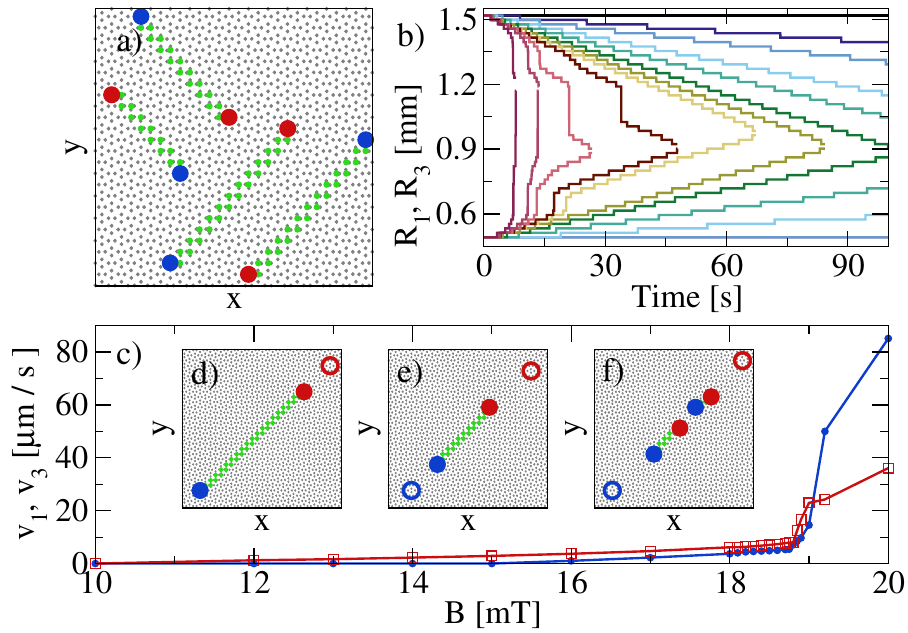
Figure 2. Defect line images and motion. ( a ) The four possible arrangements of the defect lines in a portion of the sample. Red: 3-in vertex; blue: 1-in vertex; green: biased ground state vertex; gray: unbiased ground state vertex. ( b ) The position R 1 of the 1-in (bottom lines) and R 3 of the 3-in (top lines) ends of a defect line vs time at magnetic fields B = 20, 19.2, 19, 18.85, 18.8, 18.5, 18, 17, 16, 14, 12, and 10 mT, from left to right. ( c ) The velocity v 1 (blue) and v 3 (red) of the defect ends calculated with a linear fit vs B . ( d – f ) Illustrations of the different modes of defect line contraction in a portion of the sample. Open circles indicate the original positions of the 3-in and 1-in ends, while closed circles show the final positions. ( d ) Contraction of only the 3-in end. ( e ) Contraction of both ends. ( f ) Contraction of both ends accompanied by nucleation of new defect vertices along the defect